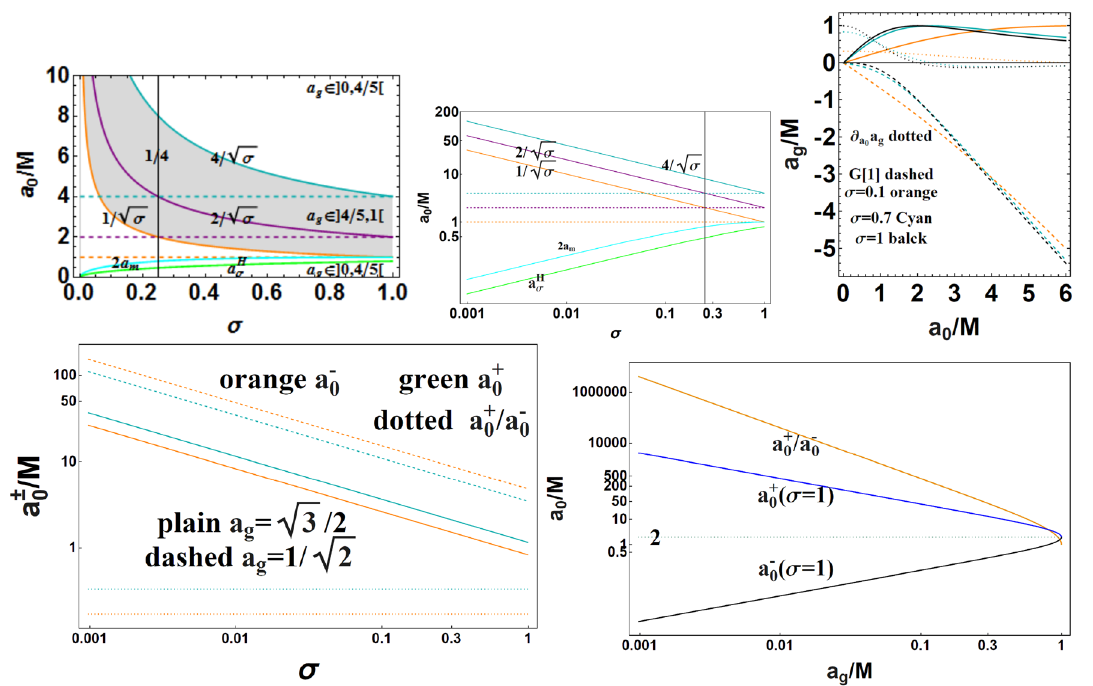
Fig. 25 Uperr line. Left panel: relation a 0 ( a g ) and regions BH-NS ori- gin a 0 to BH tangent spins a g as function of the plane σ ∈ [ 0 , 1 ] . The limiting values a 0 ∈ { 1 , 2 , 4 } are shown explicitly. In the gray region a 0 corresponds to a g ∈ [ 0 . 8 M , M ] . It refers to the analysis of Eqs. (104, 106) and (89). Center panel: logarithmic plot shows the logarithm iden- tity discussed in the text. Right panel: tangent spin a g ( a 0 ) and bundle origin spin for different planes σ , dotted line is the a g gradient. Dashed curve is G [ 1 ] ≡ a g ( a 0 ) − a 0 for different a 0 . Crossing a g curves rep-